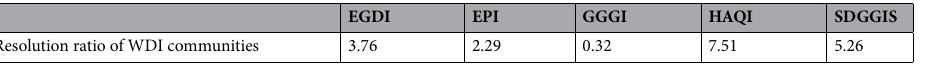
Table 1. Resolution ratio of the rankings determined by the considered indexes, with respect to the partition of the UN member states into the four development communities.